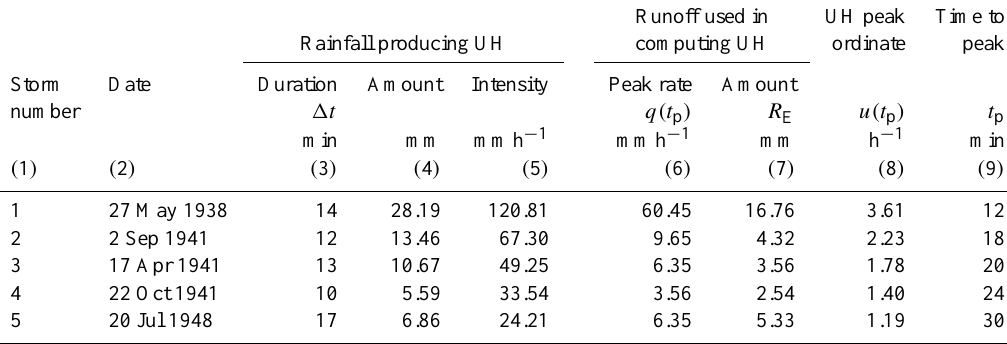
Table 2a. Unit hydrograph data for the Edwardsville catchment. Relation between rainfall intensity, unit hydrograph peak rate and time to peak. Runoff used in UH peak Time to Rainfall producing UH computing UH ordinate peak Storm Date Duration Amount Intensity Peak rate